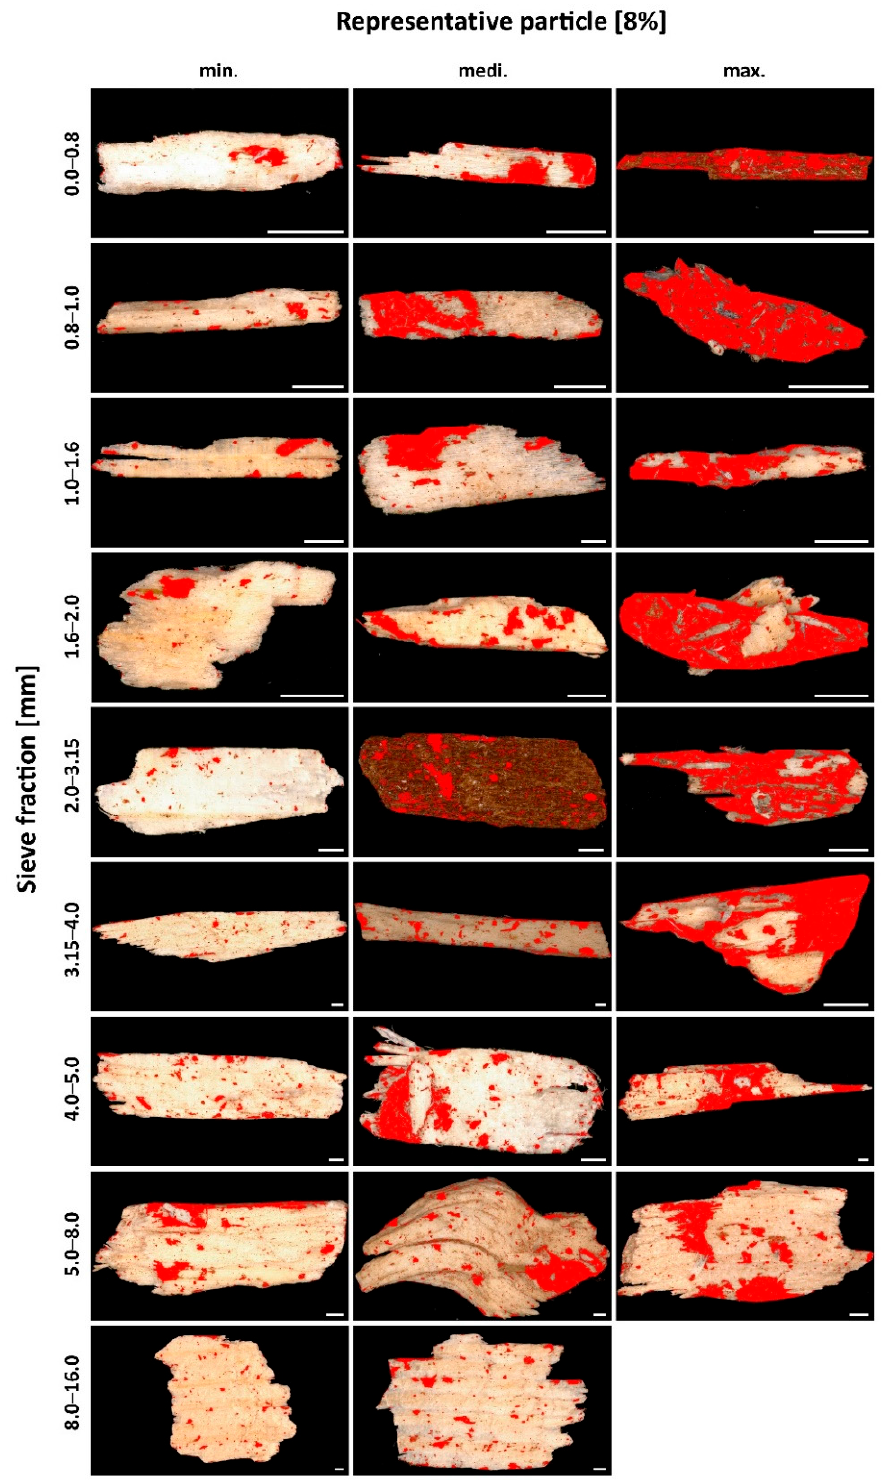
Figure 9. Particles Material 2 (AC 8%). For each of the first eight sieve fractions, a particle with the lowest degree of surface coverage, an intermediate degree of surface coverage and the highest degree of surface coverage. For the largest sieve fraction, only two particles were available for evaluation. Scale 1000 µ